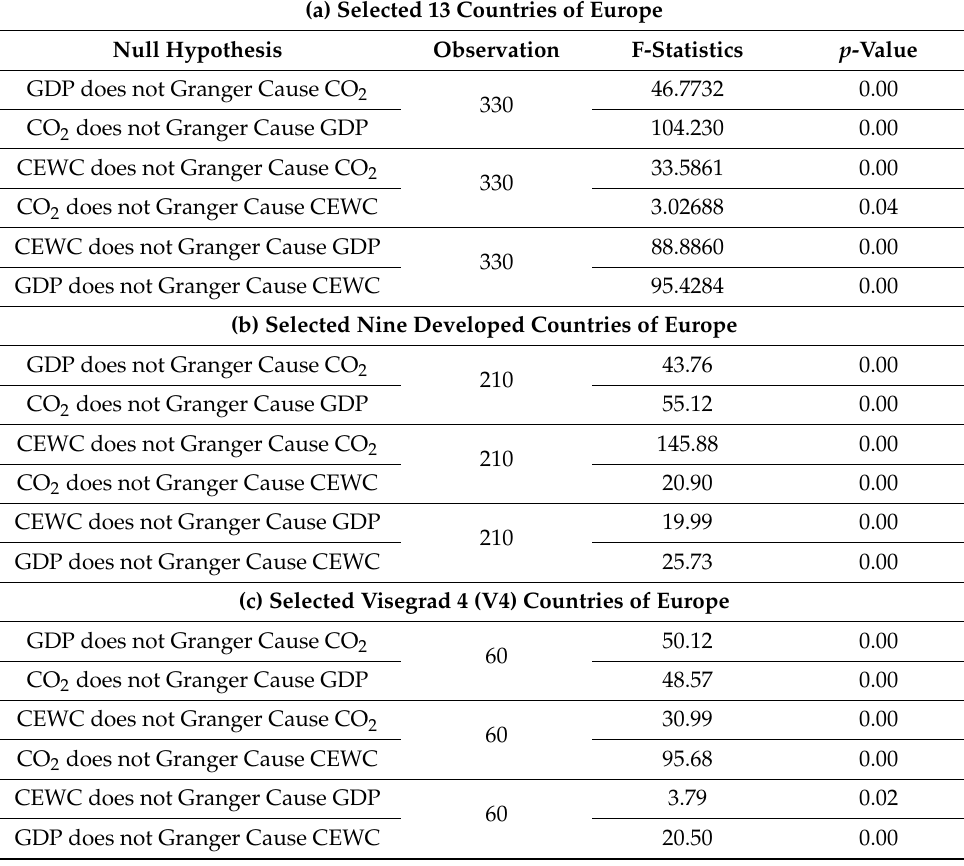
Table 7. Results of the Granger Causality